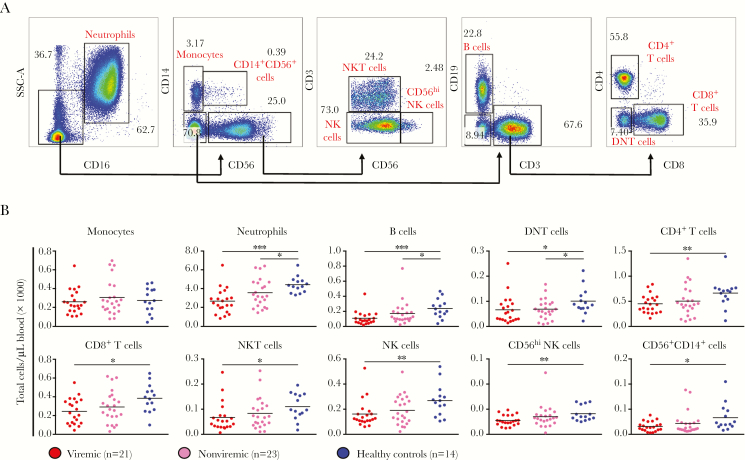
Blood immunophenotyping of patients with acute Zika virus (ZIKV) infection. Percentages of specific immune subsets were assessed via immunophenotyping of whole-blood specimens. A, Gating strategy of immunophenotyping. Briefly, immune cells were identified with a combination of CD45, CD14, CD3, CD4, CD8, CD19, CD16, and CD56 antibodies. Data in the plots shown were obtained from a representative donor. B, The cellular numbers of each identified immune subset in the peripheral blood were subsequently determined by the following formula: [percentages of specific immune subset] × [total leukocyte numbers] = cellular numbers of specific immune subset. Total leukocyte numbers were obtained with a hematology analyzer. Data were obtained from 21 viremic and 23 nonviremic patients. Values obtained from 14 healthy controls are plotted alongside for comparison. *P < .05, **P < .01, and ***P < .001 by 2-tailed nonparametric Mann-Whitney tests. DNT, double-negative T; NK, natural killer; NKT, natural killer T; SSC, side scatter.